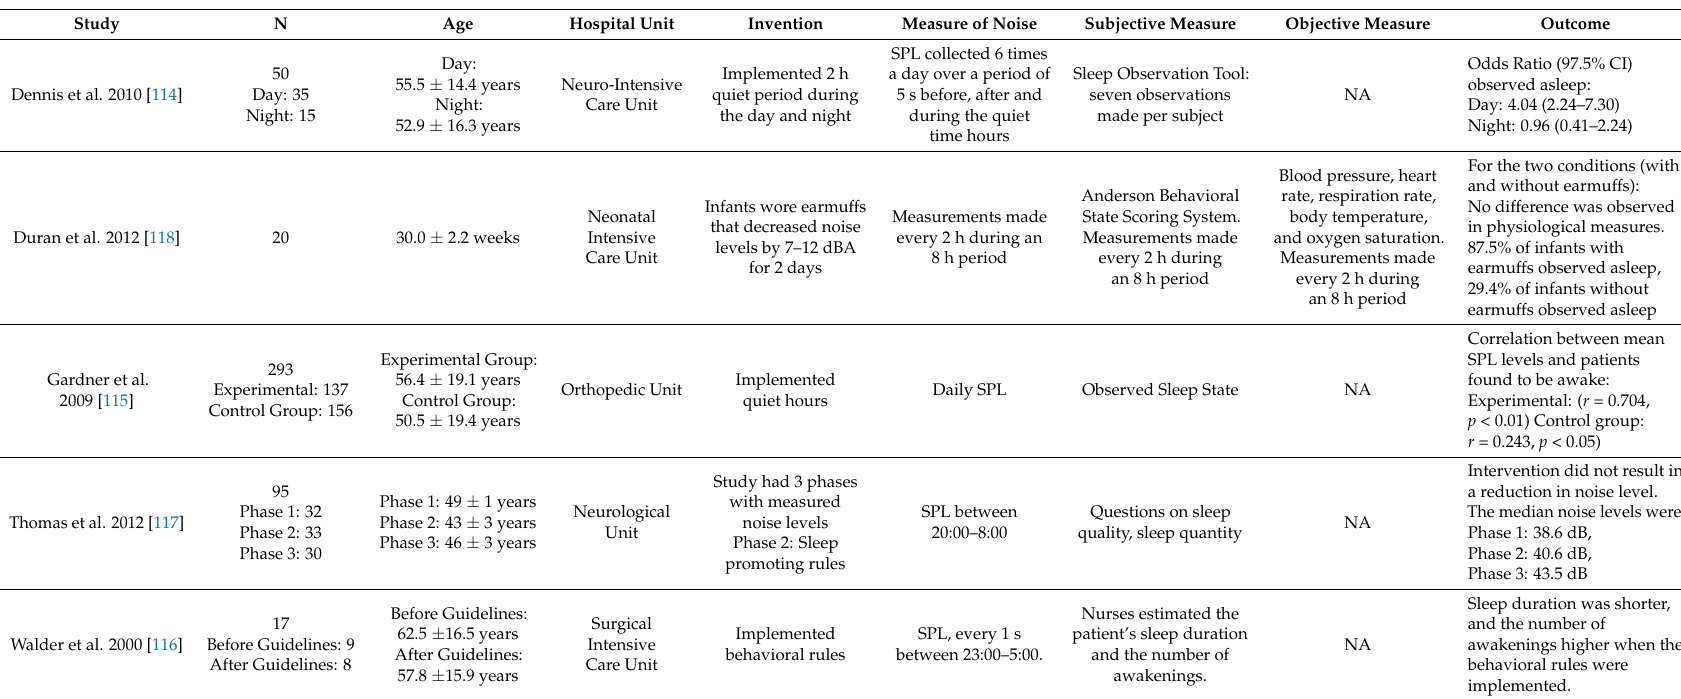
Table 10. Characteristics of intervention studies on hospital noise and sleep in adults and